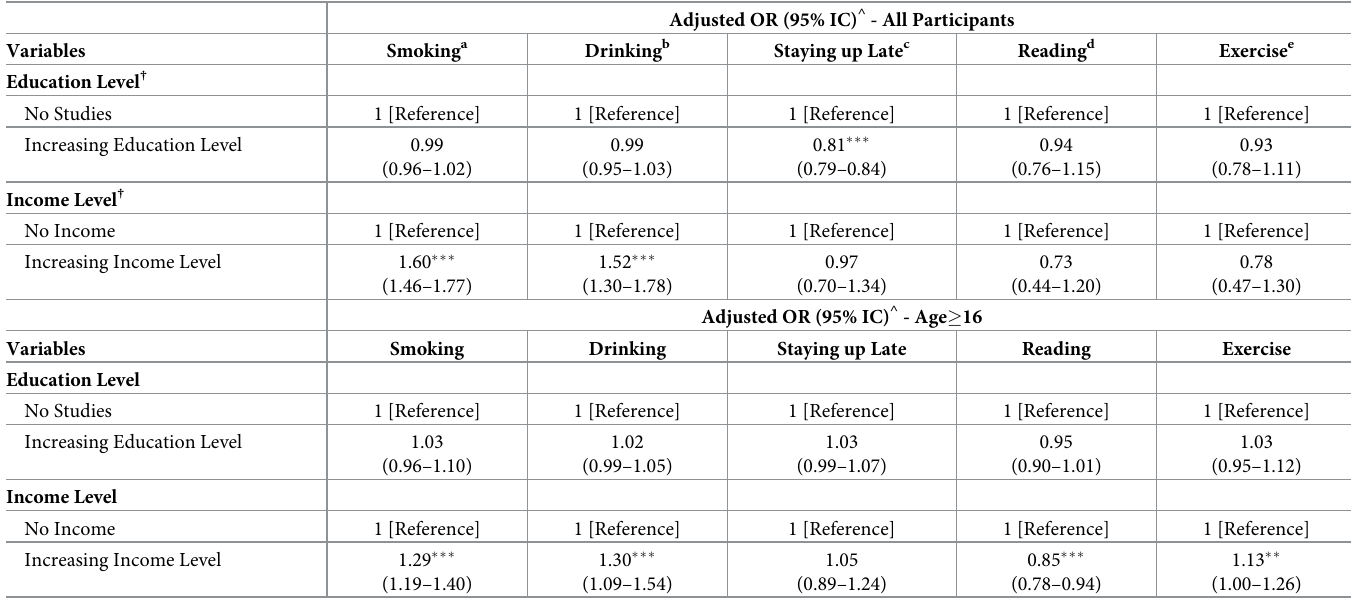
Table 5. Effects of socio-economic status on